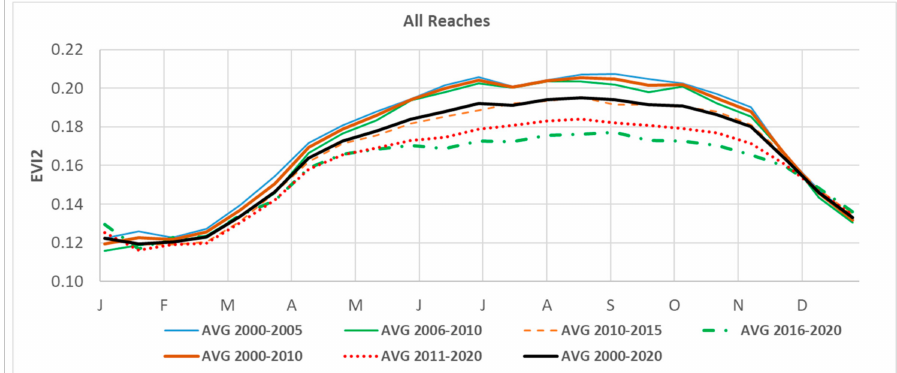
Figure 6. EVI2 time-series information for riparian vegetation on the Lower Colorado River for All reaches for the full year with months on the x -axis (J-D) for seven groups of years between 2000 and 2020 to demonstrate spatiotemporal changes across the first decade, 2000–2010 (red solid line) and the second decade, 2011–2020, (red dashed line), as well as the average for the full period, 2000–2020 (black solid line), plus four additional approximately five-year periods, 2000–2005 (blue line), 2006–2010 (green line), 2010–2015 (red dashed line), and 2016–2020 (green dashed